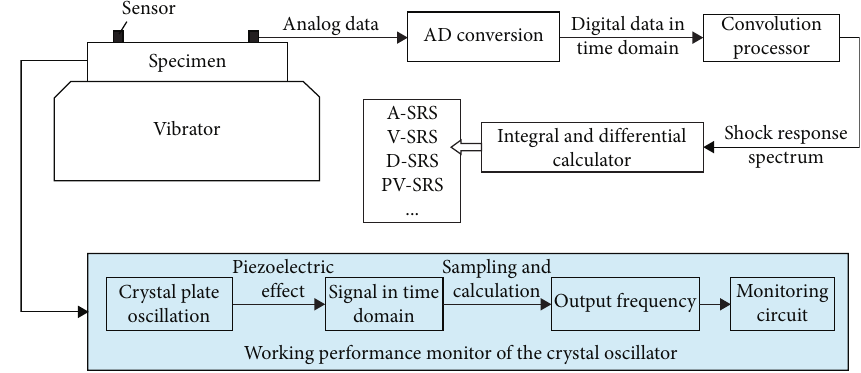
Figure 10: Data acquisition process in the experiment.